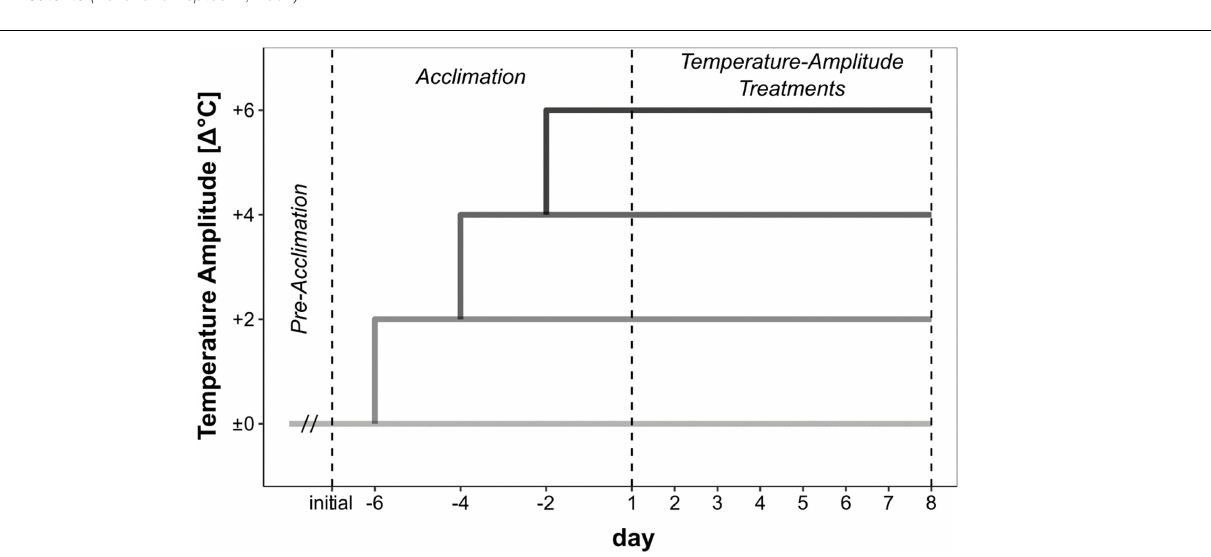
using different letters. The statistical results of overall population (P) and TA effects, and their interaction are presented in Table 4 .